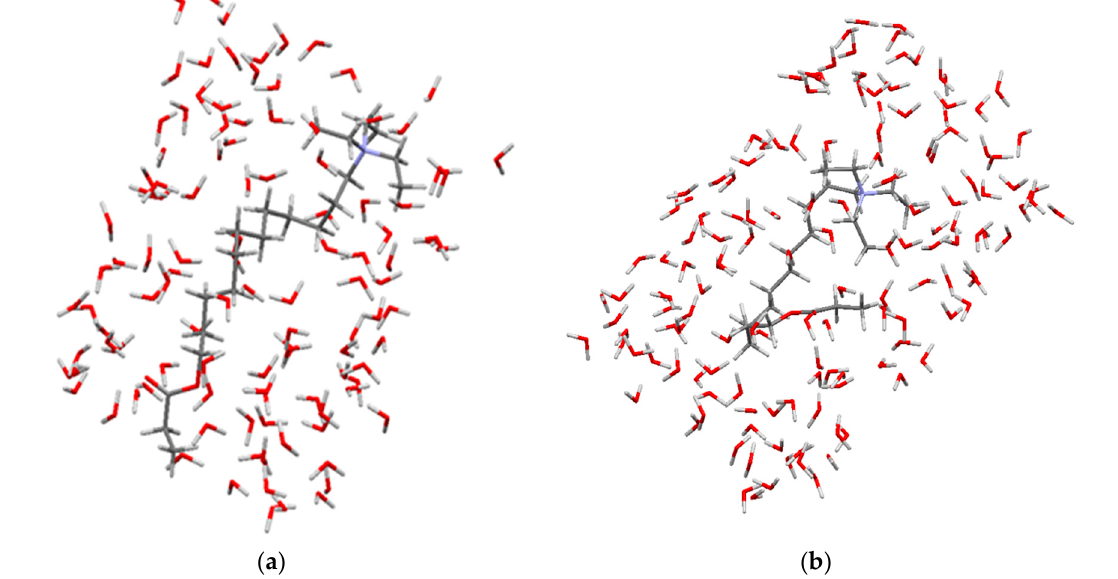
Figure 4. ( a ) QM/MM optimized structure of the AATEAB with twelve carbons in the aliphatic chain (C12) obtained using one conformer of pcg as the initial geometry; ( b ) QM/MM optimized structure of C12 obtained using one conformer of the sc group as initial geometry.